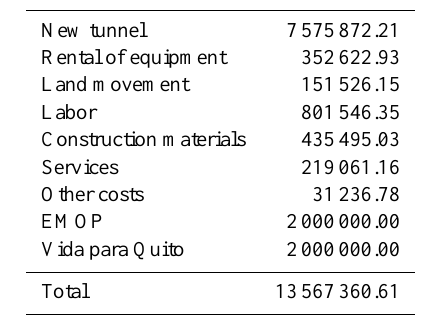
Table 2. List of the costs of the reconstruction in USD (Source: MDMQ,